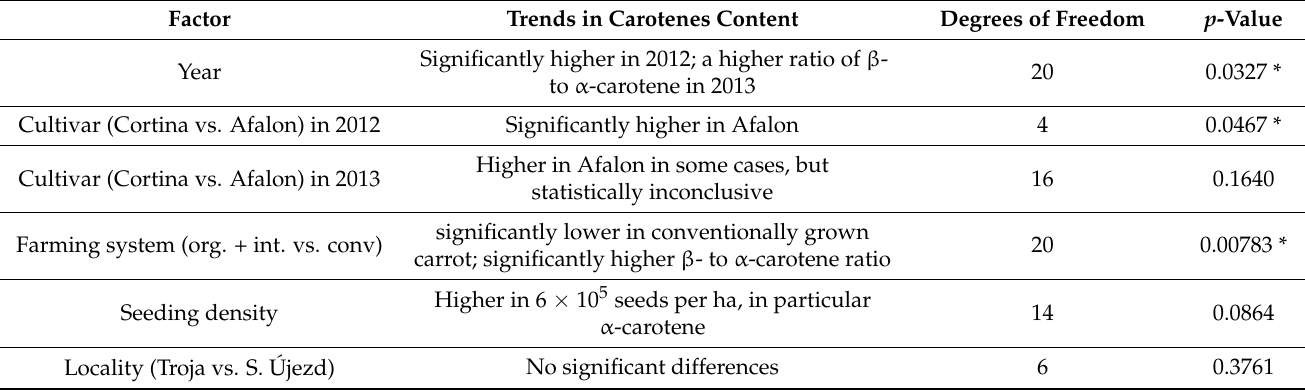
Table 1. An overview of trends in carotene levels in carrots (obtained by t -test). Factor Trends in Carotenes Content Degrees of Freedom p -Value Significantly higher in 2012; a higher ratio of β - 20 0.0327 * to α -carotene in 2013 Significantly higher in Afalon